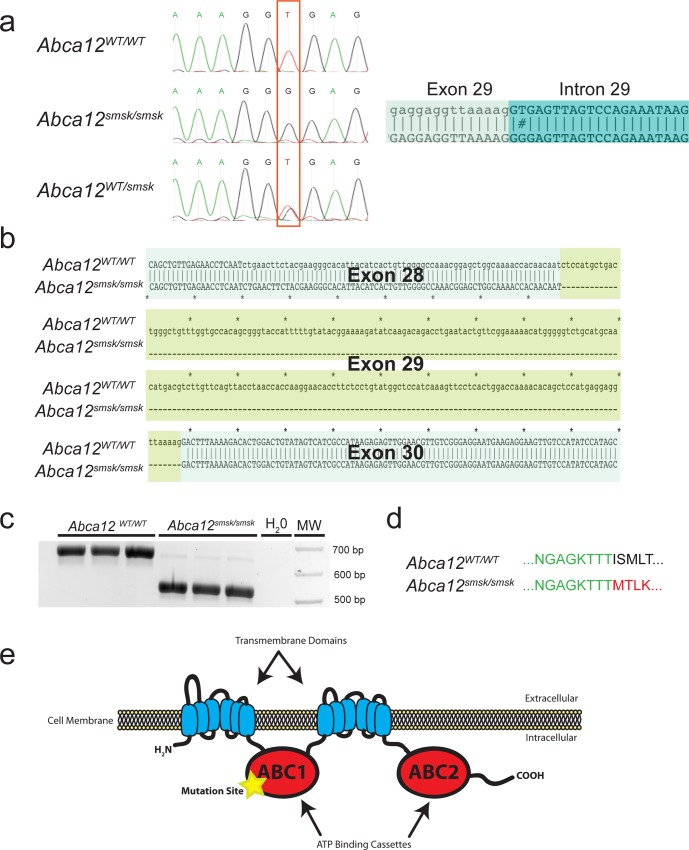
A mutation in Abca12 is associated with the smsk phenotype.(a). The recessive mutation responsible for the skin phenotype of smsk was mapped by linkage analysis to a region containing the Abca12 genomic locus. Genomic DNA sequencing showed that the wild type (WT) 5’ splice donor site “GT” in the 29th intron of Abca12 on the C57/B6 background was mutated to “GG” in the phenotypic mice. Non-phenotypic carrier mice contained both “GT” and “GG” alleles. (b) Alignment of WT and mutant Abca12 cDNA sequences showed that the splice site mutation resulted in a skipping of exon 29 in the mutant Abca12 mRNA and would produce an in-frame deletion of amino acids encoded by exon 29 in the mutant protein. (c) The cDNA fragments of Abca12 encompassing exon 28 to 31 were amplified by RT-PCR from skin RNA of WT (764bp) and smsk mutant (HI, 545bp) mice. The bands were resolved by agarose gel electrophoresis. (d) In silico translation analysis predicted that the smsk mutation results in a truncated protein with an in-frame fusion between amino acid sequences encoded by exons 28 (green) and 30 (red). The normal sequence encoded by the splicing of exon 28 to exon 29 is shown in black. (e) Alternative splicing skips exon 29, leading to an in-frame deletion of 73 amino acids from the first ATP-binding domain of ABCA12.